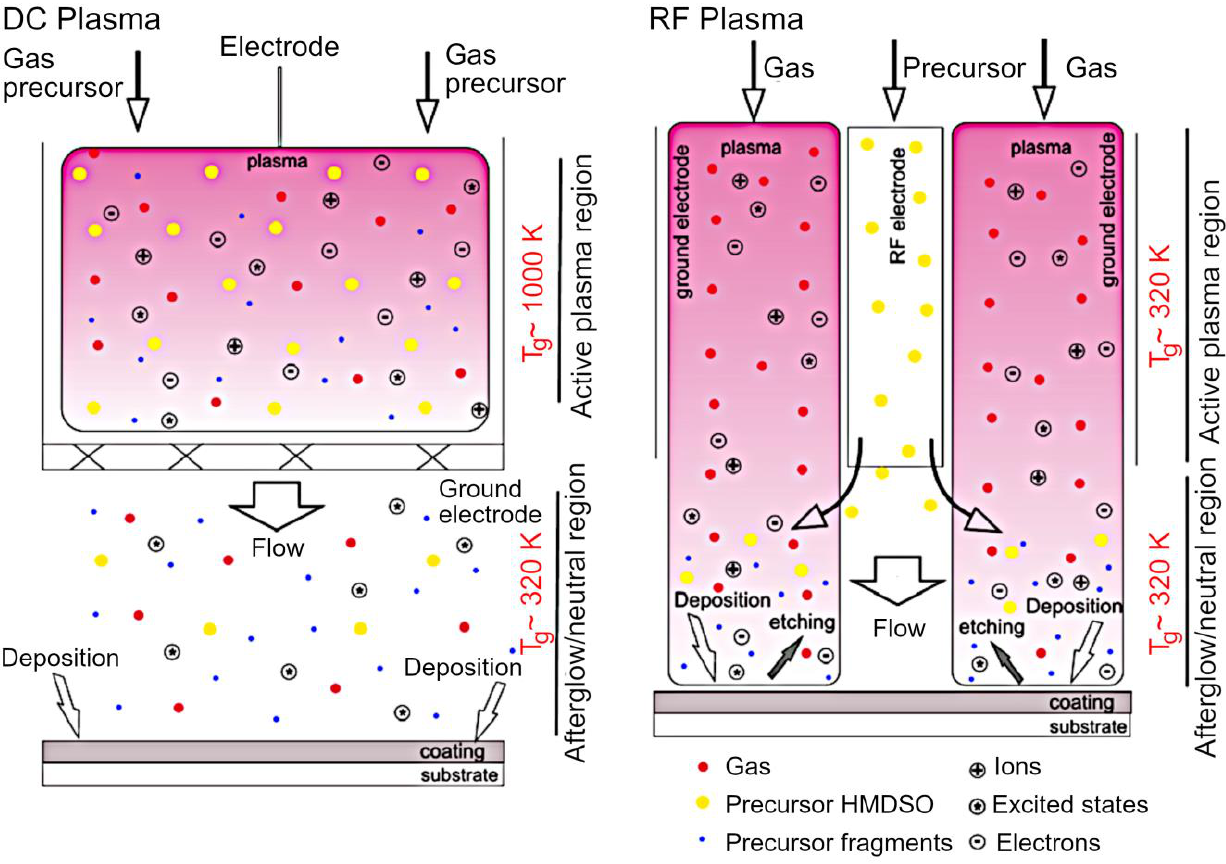
Figure 14. Schematic representation of the deposition process in DC and RF plasma jet. Films with lower fraction of carbon were fabricated using RF plasma, with the outcome related to the difference in the injection point of the source material. Reproduced from Kuchakova et al. (2020) [95] under conditions of the CC BY